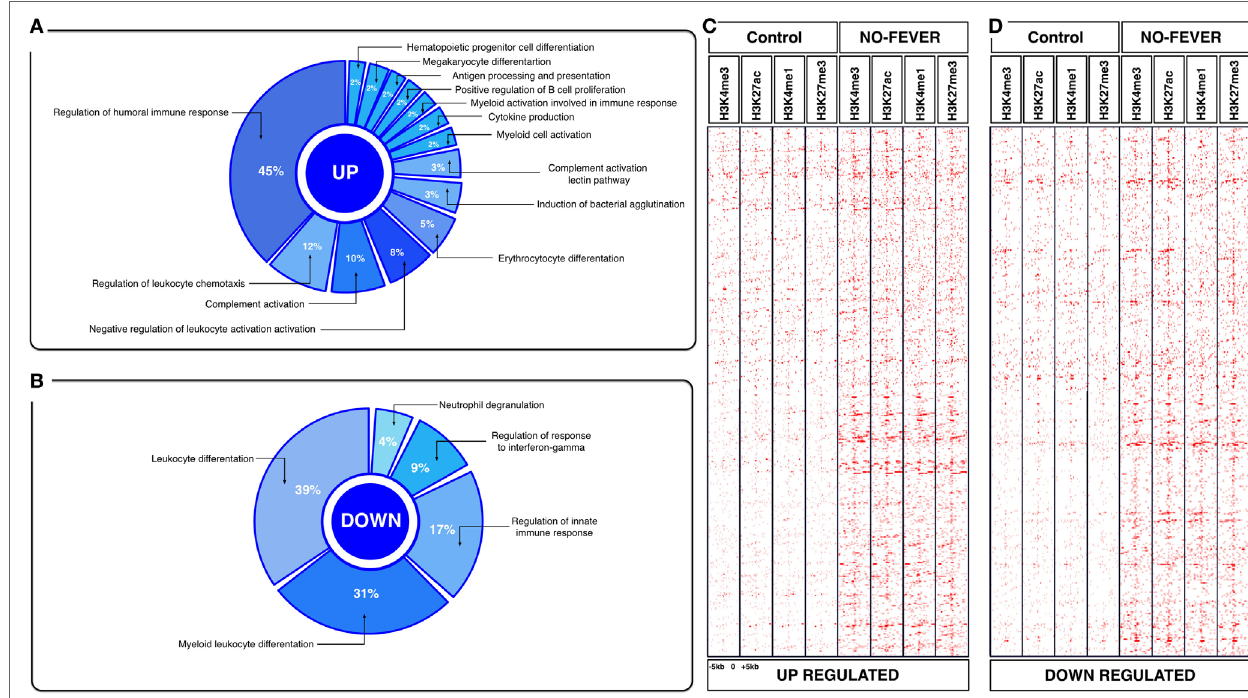
FigUre 5 | Effects of constant temperature on the immunological process and histone landscape. Gene ontology enrichment analysis of transcripts involved in immune process in pronephros of no fever individuals (GO DAVID and ClueGo Cytoscpae Plugin). (a) Upregulated genes and (B) downregulated genes. (c,D) Heat map showing chromatin immunoprecipitation-seq read density (log2 transformed) for the indicated of 1,369 RTR − / − genes referenced in salmon ENSEMBL database (down and up) at equivalent genomic regions in 5-kb windows upstream and downstream of the TSS binding sites (TSS; assumed to be at the 5 kp end of annotated genes). The specific genes were sorted into categories based on enrichment H3K4me1, H3K4me3, 3K27me3, and